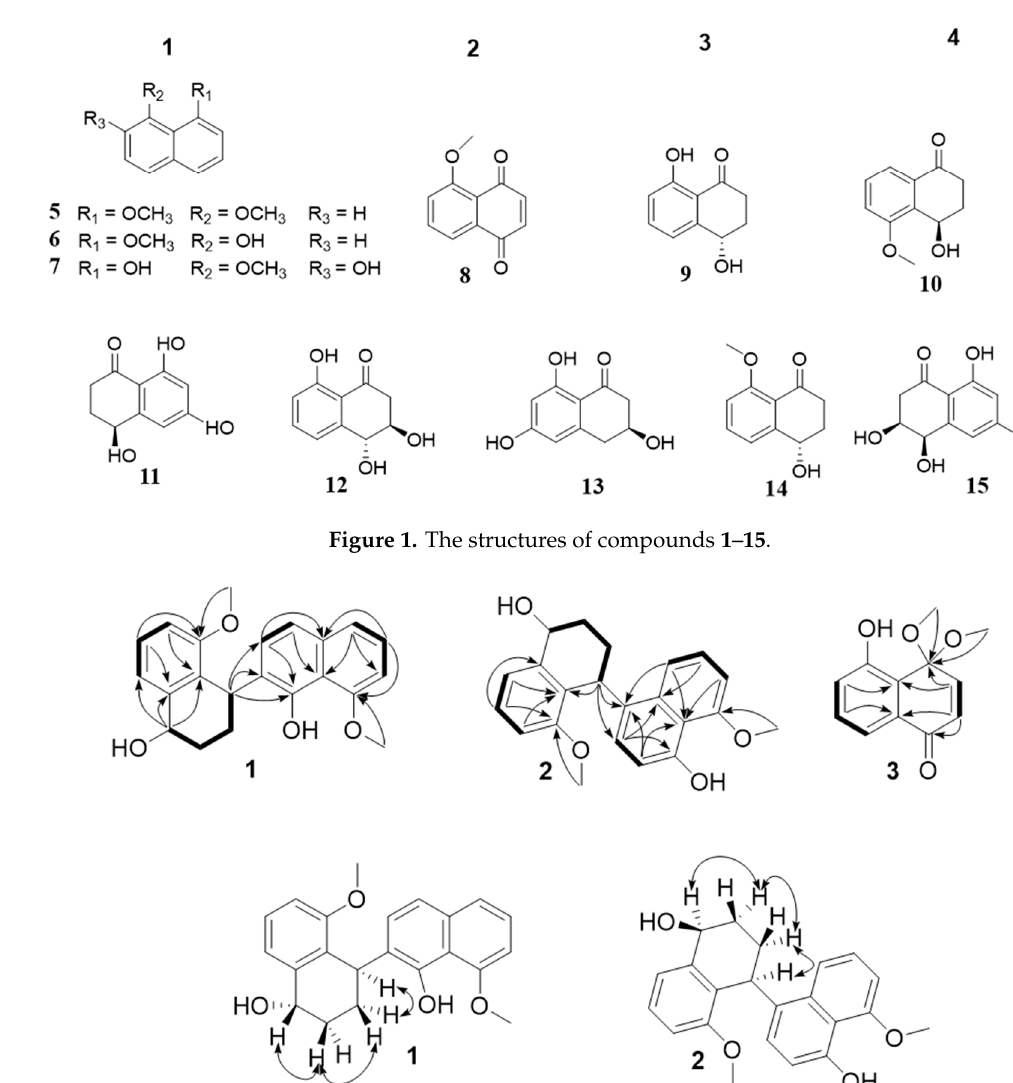
Figure 2. Key 1 H- 1 H COSY ( ▬ ), HMBC (H → C), and ROESY ( ↔ ) correlations of 1 – 3 . Table 1. 1 H (500 MHz) and 13 C-NMR (125 MHz) Data of Compounds 1 – 2 (in CDCl 3 ).